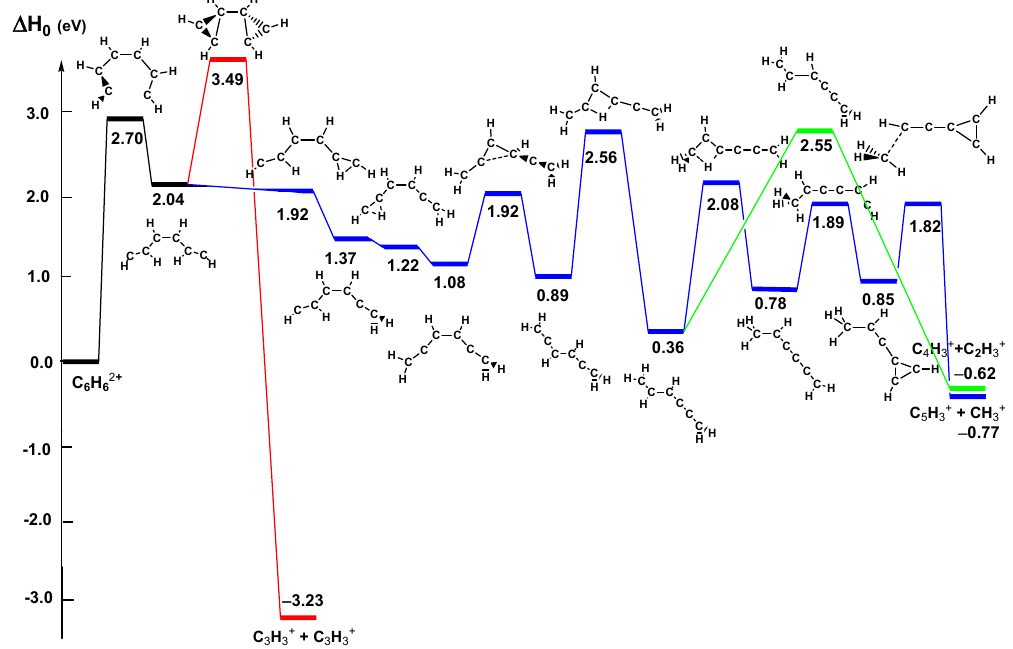
Figure 9. Potential energy surface of the selected dissociation channels of C 6 H 62+ computed at CCSD(T)/6-311++G(3 df ,3 pd )//B3LYP/6-311+G( d ) level. Relative energies (eV) at 0 K with inclusion of zero point energy correction with respect to C 6 H 62+ .